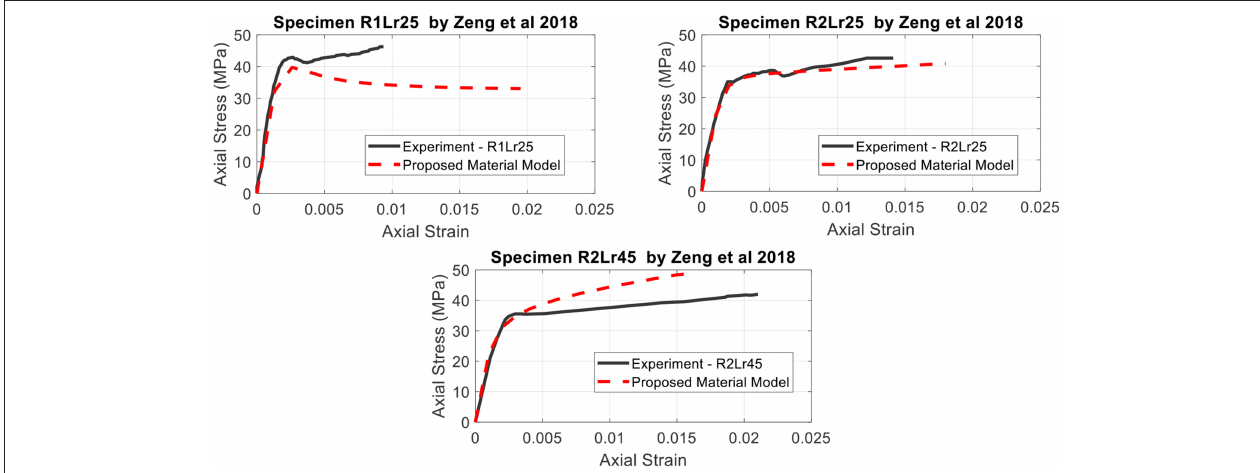
FIGURE 13 | Correlation of the proposed material model with experimental results of large-scale CFRP-confined rectangular RC columns under axial compression by Zeng et al. (2018).